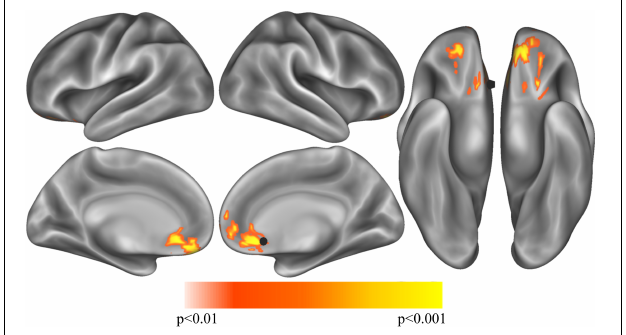
FIGURE 2 | Exploratory analysis correlation sgCC RSFC seedmaps correlated with mean unlock duration identified a cluster with a positive relationship to unlock duration in the ventromedial prefrontal cortex ( p < 0.01, volume corrected using ACF to p < 0.001) shown on inflated lateral (top left), medial (bottom left) and ventral (right) cortical surfaces. The sgCC seed is represented as a black 10 mm sphere, larger than the 4 mm sphere used to create the seedmaps for visualization purposes.